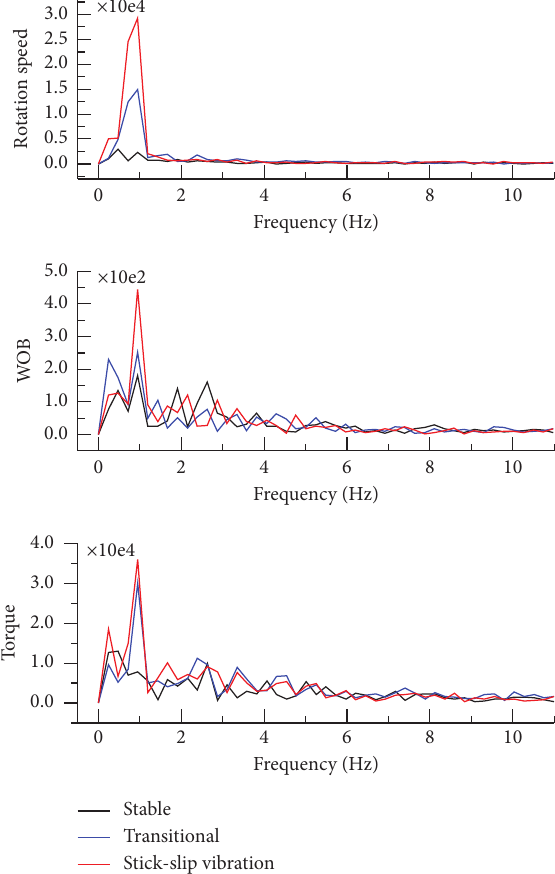
Figure 4: Frequency spectrum of rotation speed, WOB, and torque.